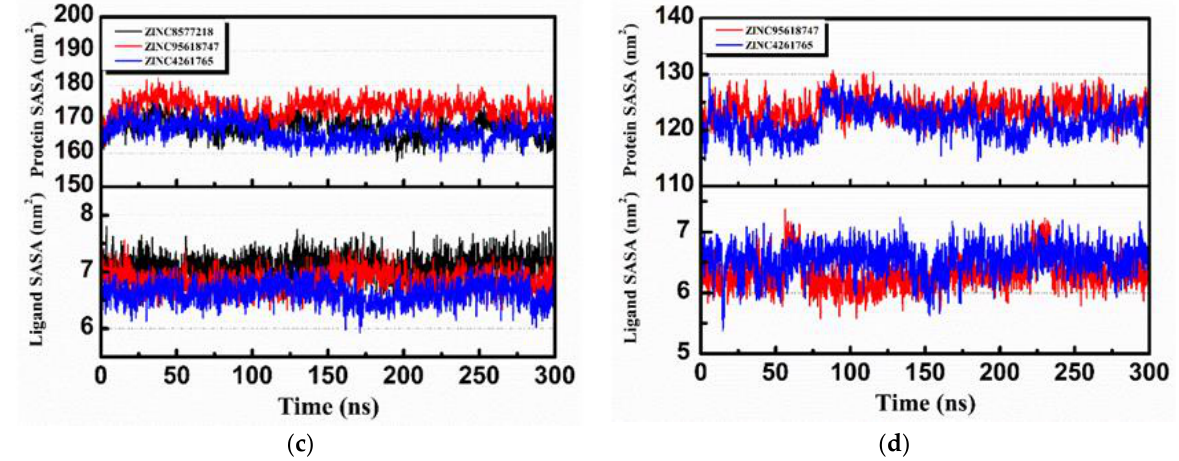
Figure 17. Mean square displacement (MSD) and solvent accessible surface area (SASA) analysis of each receptor–ligand complex in molecular dynamics simulation. ( a ) MSD of the protein and ligand of DHODH complexes. ( b ) MSD of the protein and ligand of UMPS complexes. ( c ) SASA of the protein and ligand of DHODH complexes. ( d ) SASA of the protein and ligand of UMPS complexes.